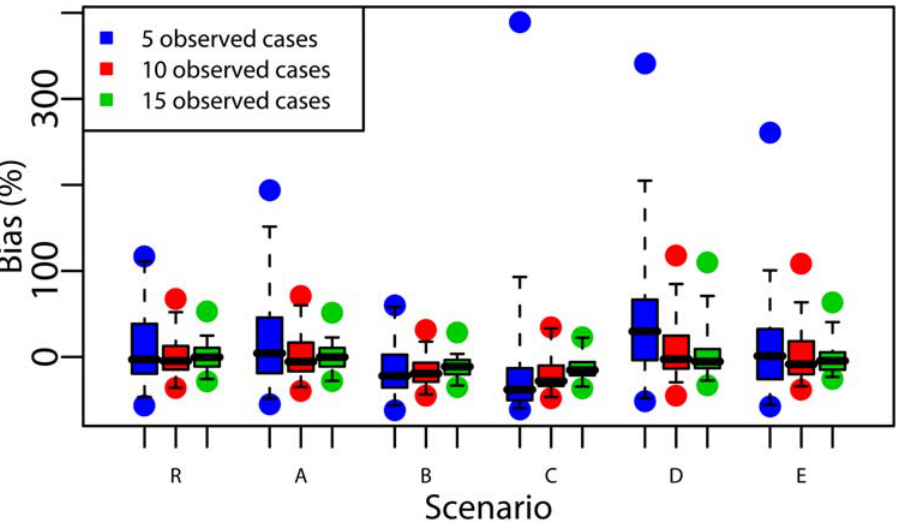
Figure 4. Performance of the back-calculation method to predict the outbreak size with Reference scenario (R) and scenarios A to E. Each box-plot represents the distribution (minimum, maximum, percentiles 2.5,25,50,75,97.5) of the predicted outbreak size relative bias based on the 5, 10 and 15 first cases on 40 simulated outbreaks per scenario.